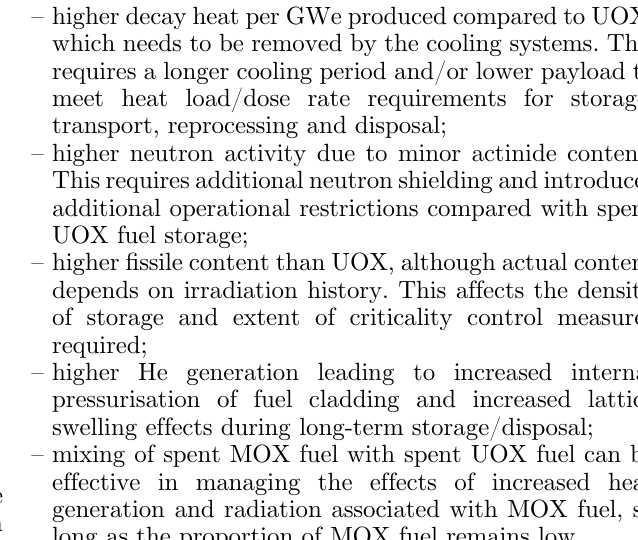
Fig. 5. Loading a canister into a horizontal concrete storage module (Courtesy of Areva TN